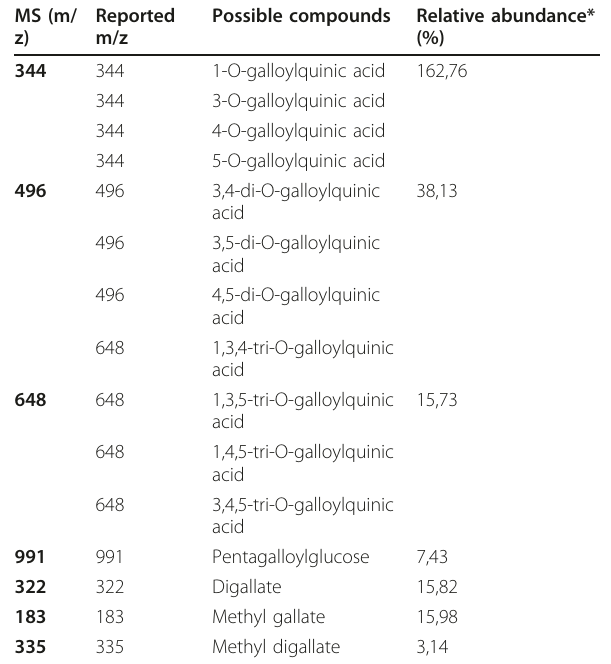
Table 1 Compounds in the P2Et fraction.